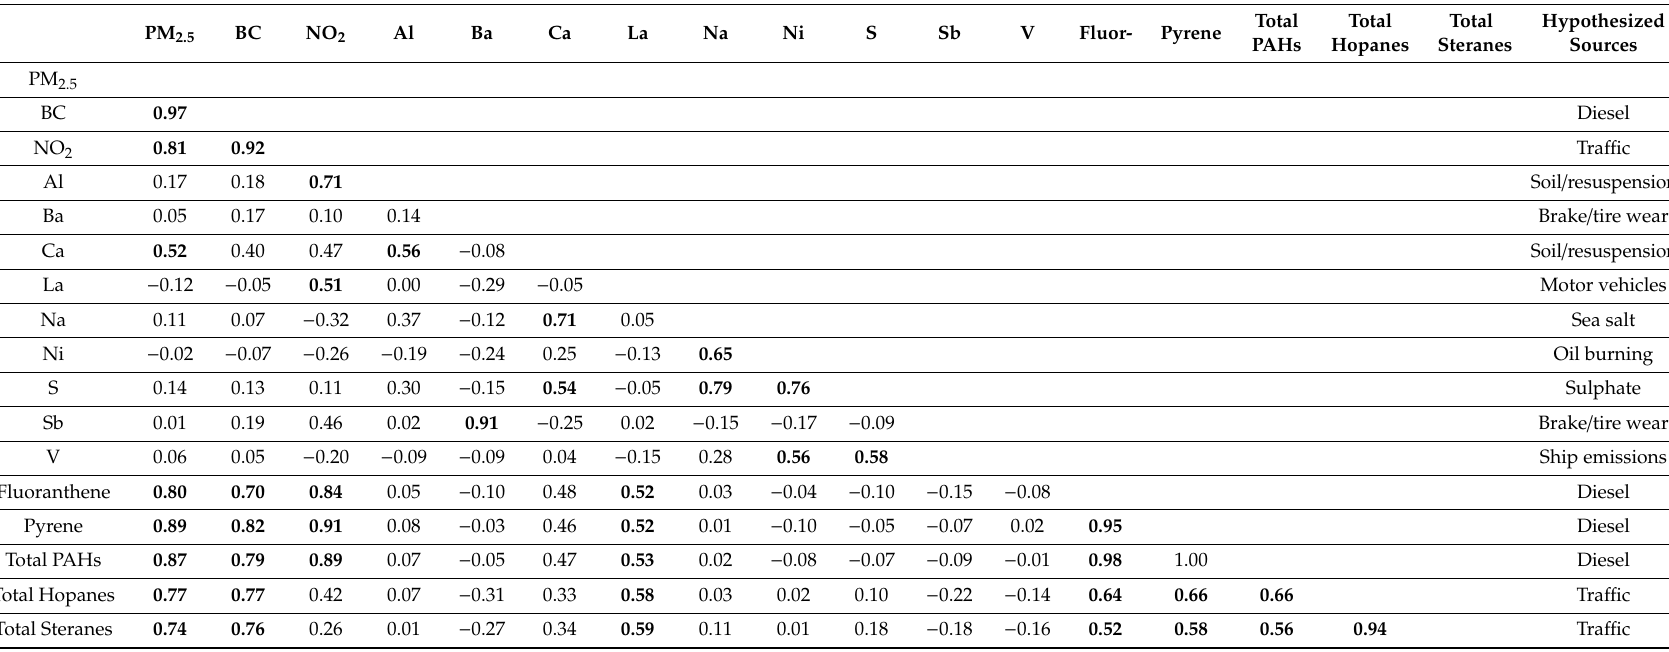
Table 2. Spearman correlations for concentrations across sites, and hypothesized sources. Total PAHs includes fluoranthene and